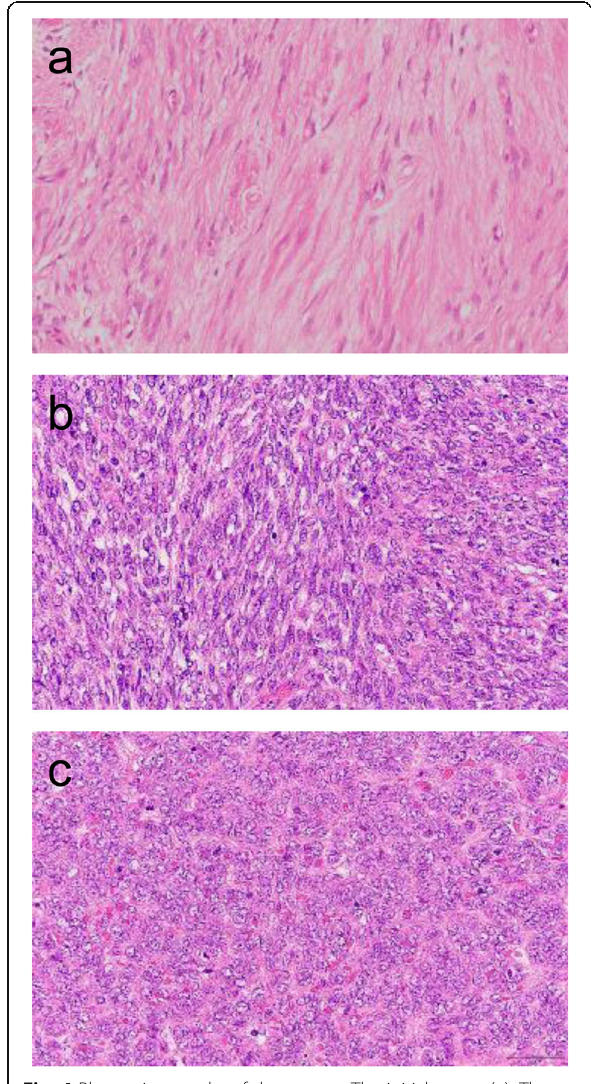
Fig. 4 Photomicrographs of the tumors. The initial tumor ( a ). The secondary tumor ( b ). The tertiary tumor ( c ). The pathological grade was noted to increase for every surgery, based on the number of round cells, cellularity, the size of the nuclei, the degree of atypism, and the number of